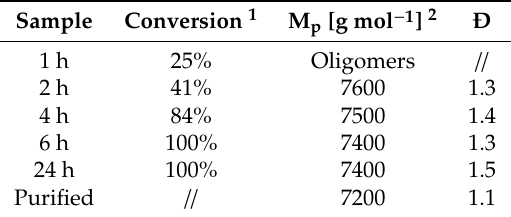
Table 3. Conversion and molecular weight growth during the Me 3 DOX